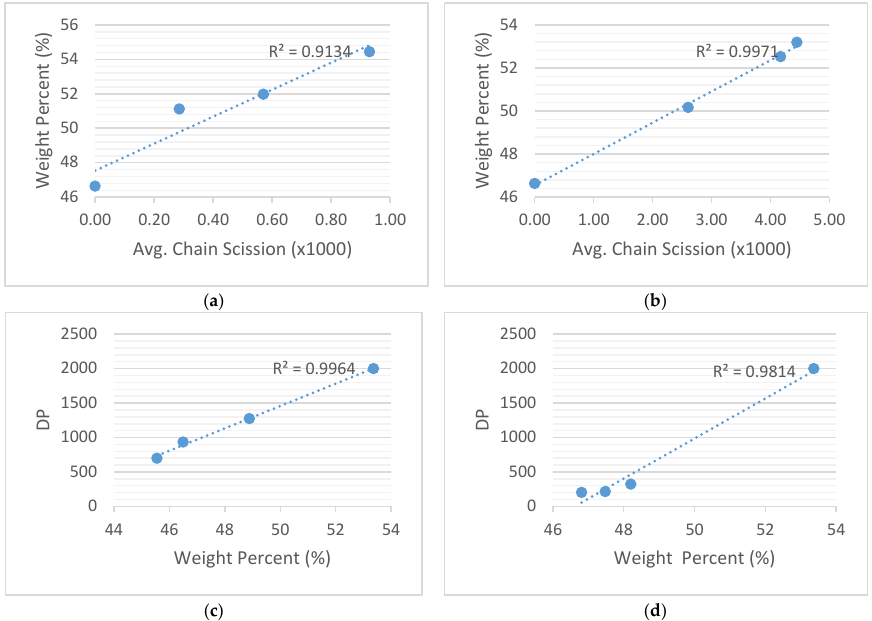
Figure 16. Correlation between average number of chain scission of transformer insulation paper and weight percent of C element ( a ) 120 °C; ( b ) 150 °C and Correlation between DP of transformer insulation paper and weight percent of O element; ( c ) 120 °C; ( d ) 150 °C. Table 5. Correlation between average number of chain scission and functional group/chemical element of transformer insulation paper.